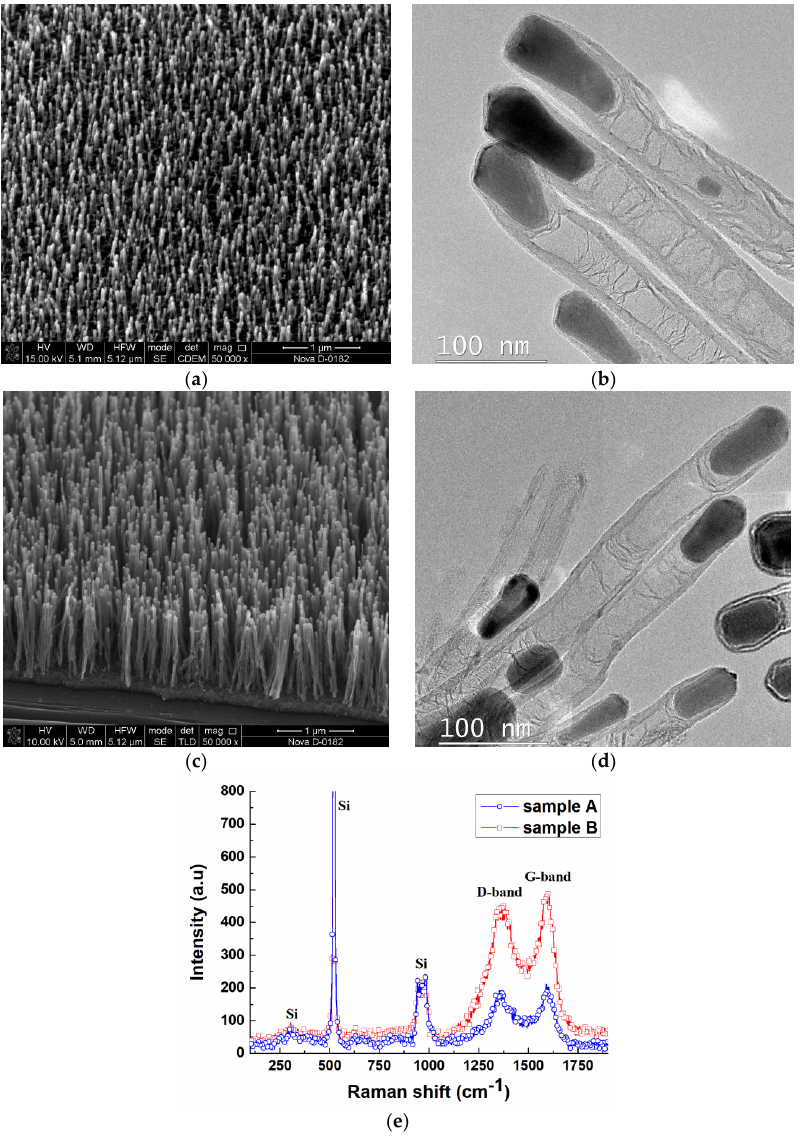
Figure 1. The experimental samples of vertically aligned carbon nanotube arrays: ( a,c ) SEM images of samples A and B, respectively; ( b,d ) TEM images of samples A and B, respectively; ( e ) Raman spectra of samples A and B.